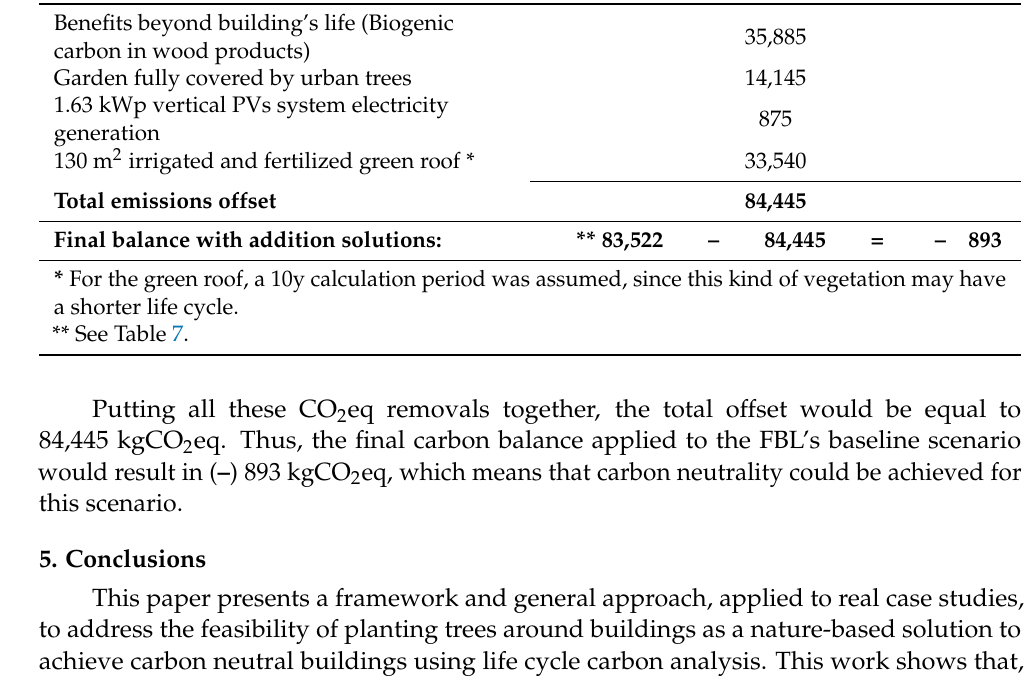
Table 12. CO 2 offset from additional strategies in FBL (kgCO 2 eq over life